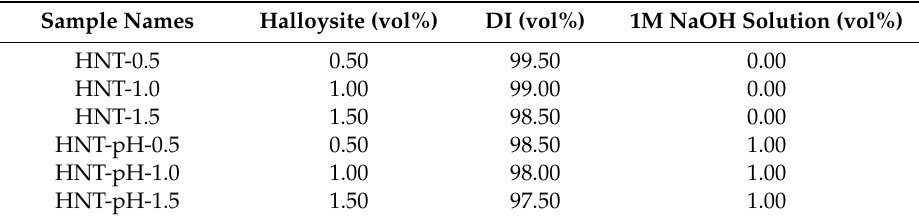
Table 1. Specification of halloysite nanofluid